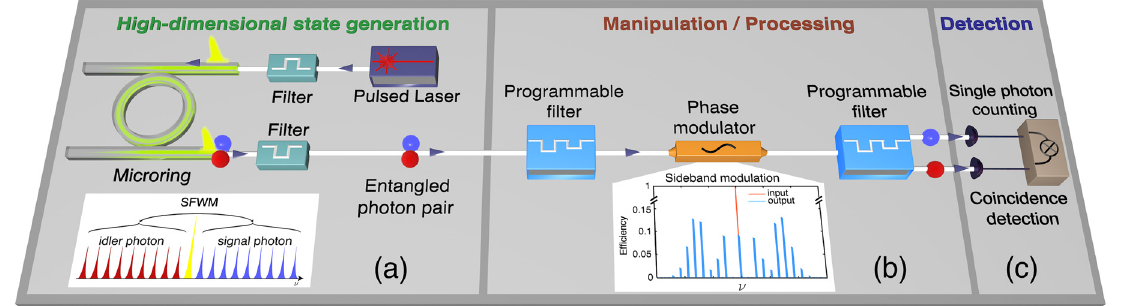
Figure 1: Scheme for the generation (a), manipulation/processing (b), and detection (c) of multi-level frequency-entangled photon pairs. The inset in the left panel depicts the signal and idler photons being generated in a superposition of multiple frequency modes. The inset in the central panel reports the sidebands produced by the phase modulator for shifting and mixing the frequency modes. Adapted from